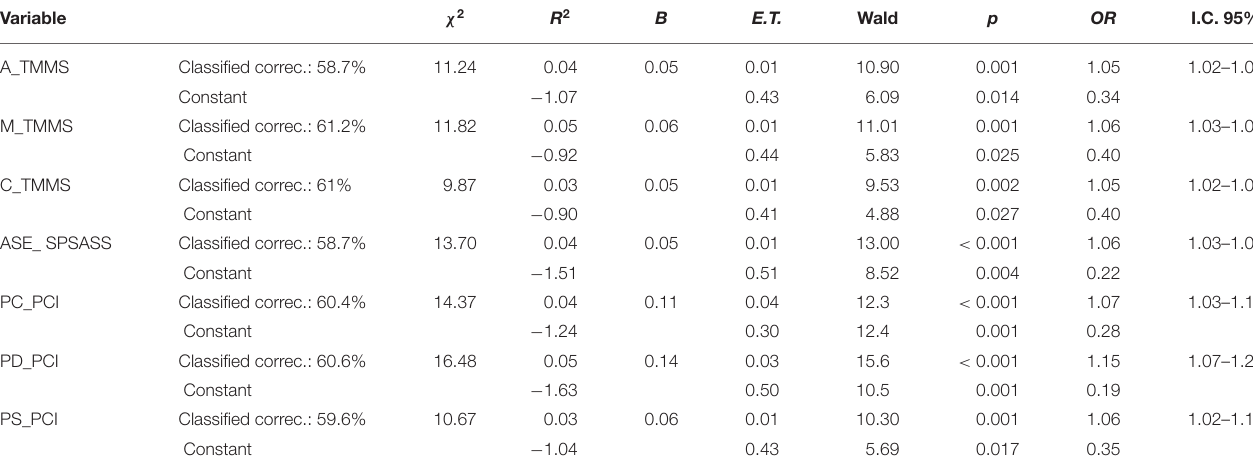
TABLE 2 | Binary logistic regression for the probability of presenting high scores in aesthetic musical awareness based on emotional intelligence, academic self-efficacy, and perfectionistic automatic thoughts. Variable χ 2 R 2